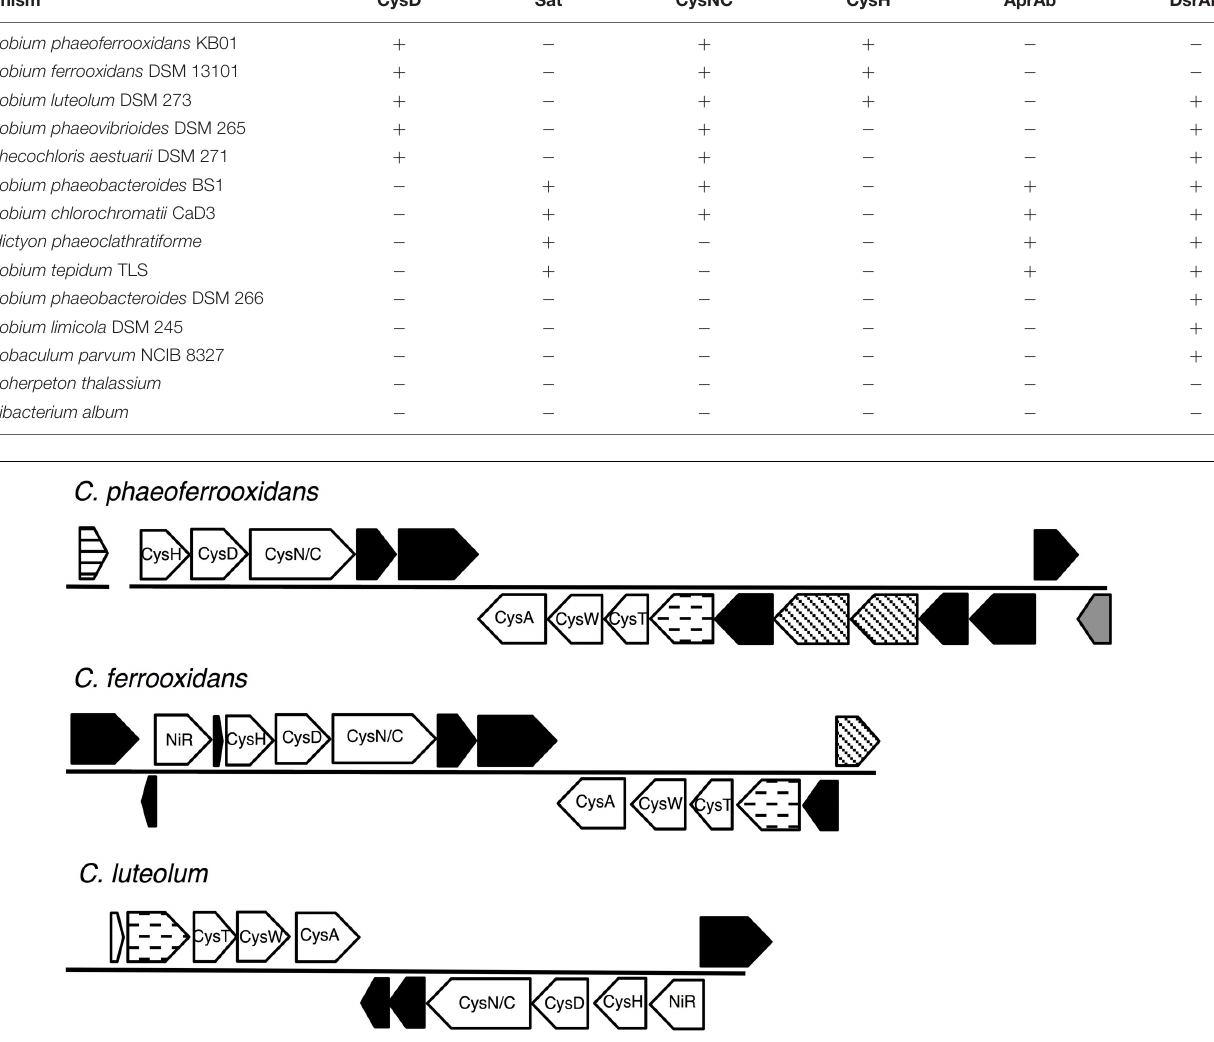
TABLE 2 | Assimilatory (orange) and dissimilatory (blue) sulfur proteins present in the genomes of green sulfur bacteria. Organism CysD Sat CysNC